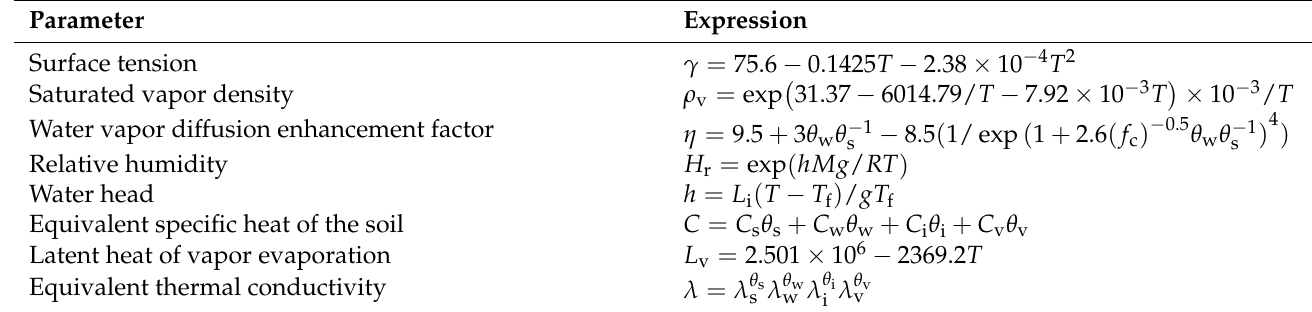
Table 1. Expressions of other hydrologic and thermal